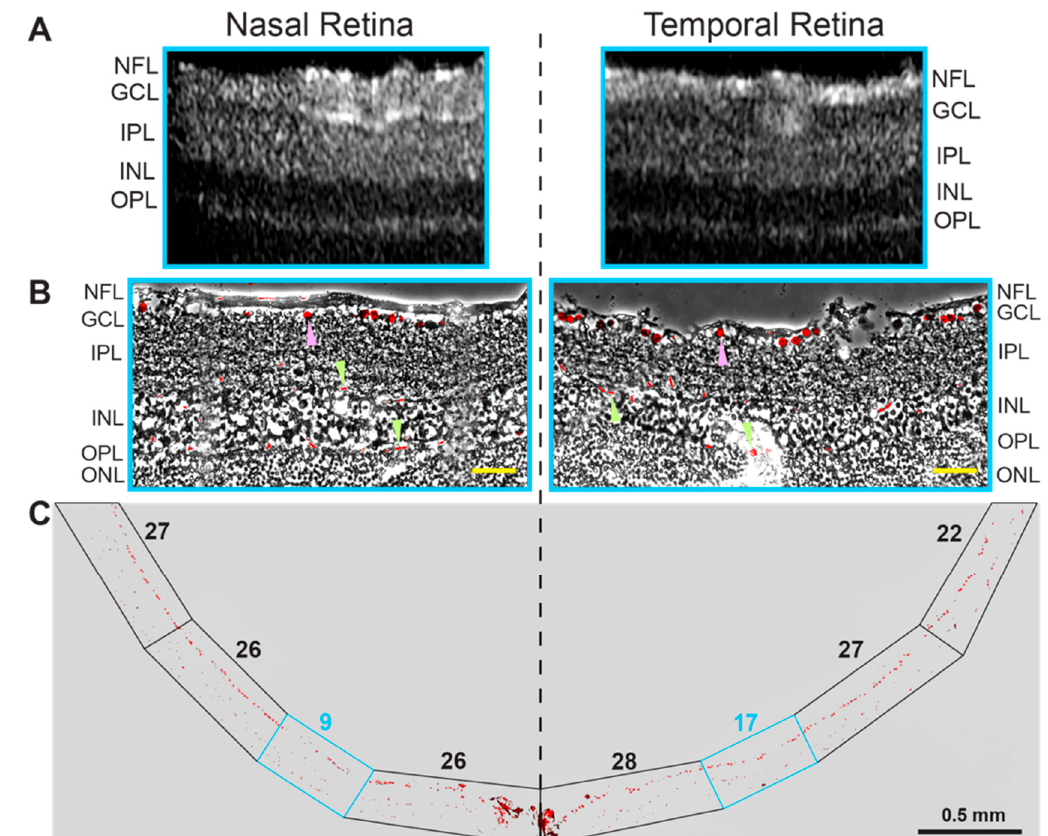
Figure 3. Localization of area centralis in hamster retina. Images of a representative retina (2 female and 3 male hamsters) were used, which was characterized by SD-OCT ( A ) and a stain for BRN3A ( B , C ). ( B ): An overlay of the BRN3A stain on the phase contrast image of the retina, which corresponds to the region in the cyan box in ( A , C ). Magenta arrowheads point to the BRN3A staining of the ganglion cells, whereas green arrowheads indicate staining of red blood cells inside the retinal blood vessels. ( C ): the BRN3A staining of the entire retinal cross section. Boxed regions indicate segments of the retina, in which the BRN3A-positive cells in the ganglion cell layer were counted and indicated by a number above the boxed region. The retinal layer labeling is as described in Figures 1 and 2. Yellow scale bars = 50 µm.